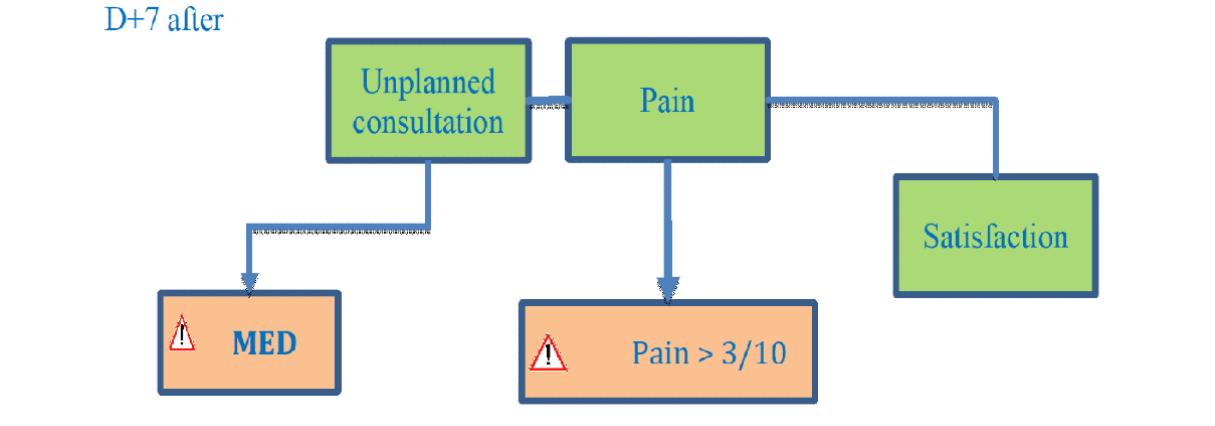
Figure 4. Short message service text pattern day 7 after